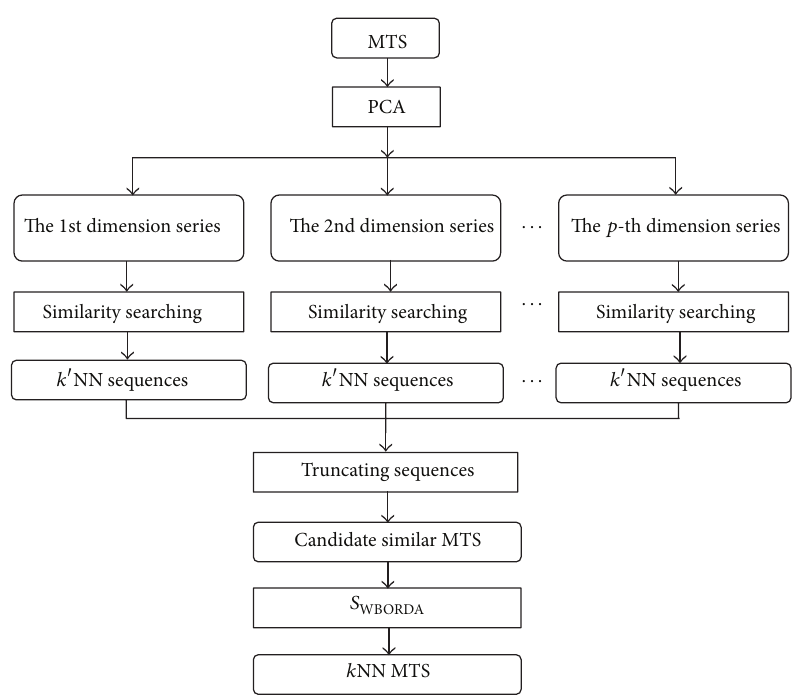
Figure 1: The model of similarity searching on weighted BORDA